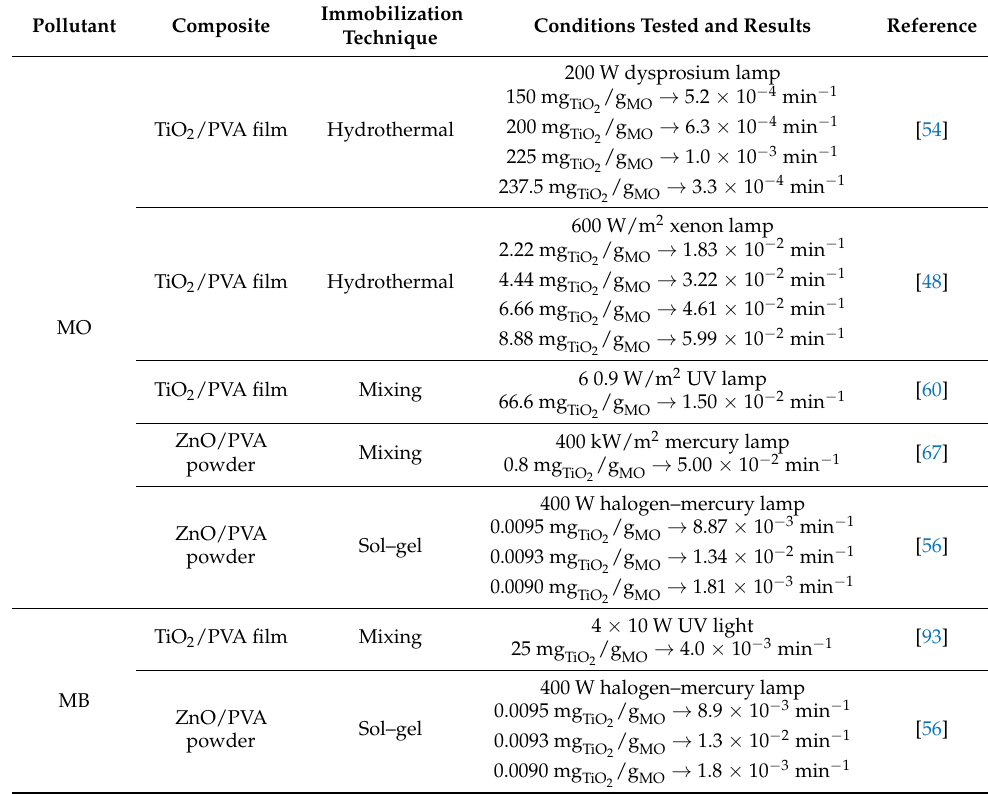
Table 13. Immobilization technique effect on the kinetic rate of the PVA-supported photocatalysis